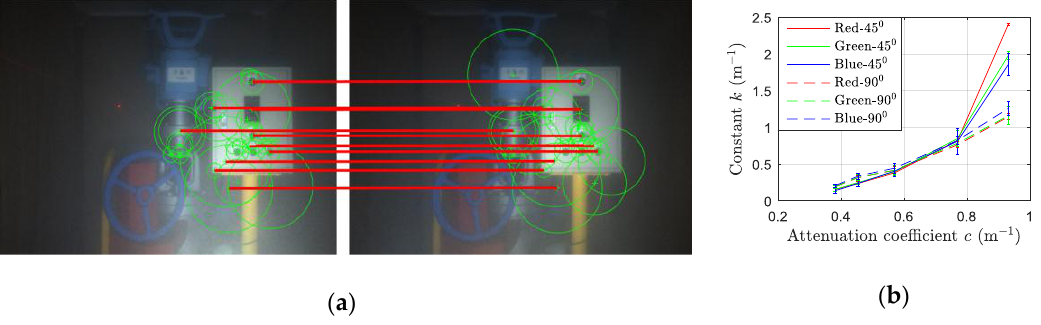
Figure A1. Effect of polarizization: ( a ) Correspondences between left-right images; ( b ) Constant k estimation, which is attenuation coefficient dependent.